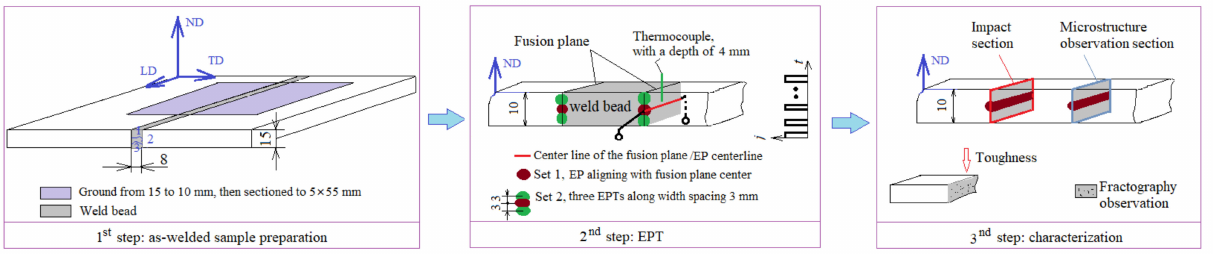
Figure 1. Schematic of the EPT process